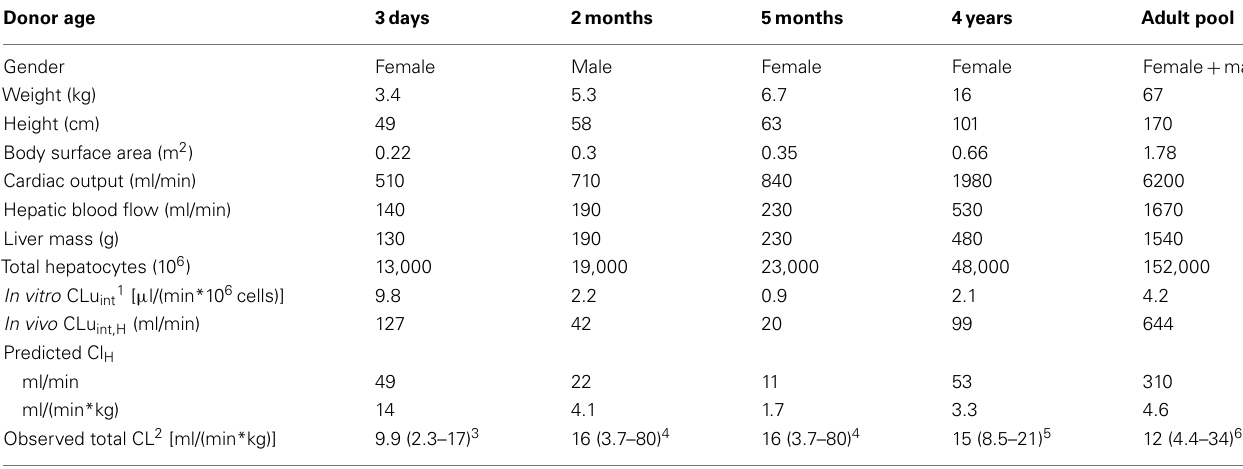
Table 3 | Prediction of hepatic plasma clearance of oxycodone using in vitro clearance in hepatocytes and physiological parameters. Donor